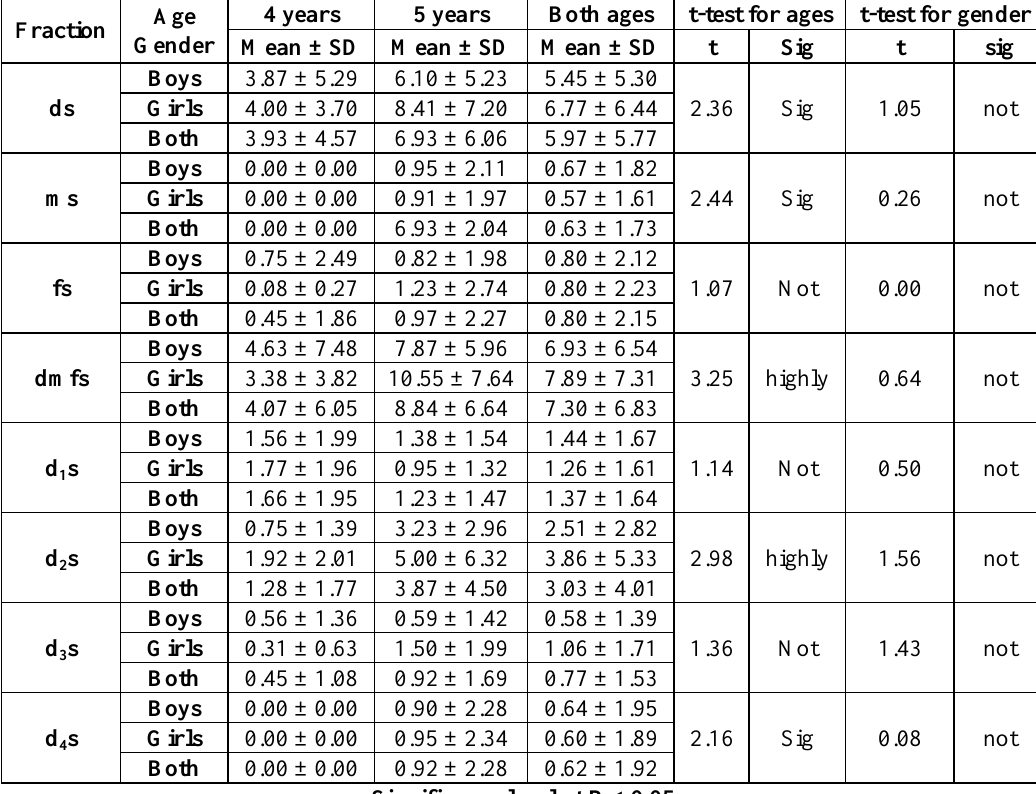
Table 5: Caries Experience among Children by Age and Gender